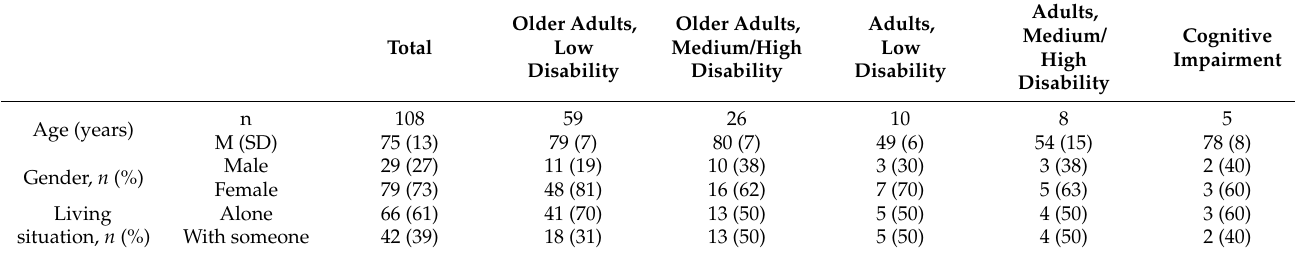
Table 2. Study population description, total sample, and profile per